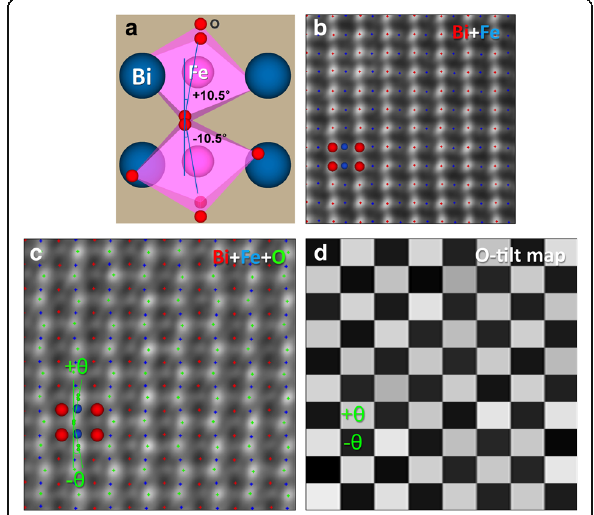
Fig. 2 Measurement of oxygen octahedral tilts in BFO using HAADF and BF STEM images. a Schematic of the BFO structure observed along the [110] pc direction. b , c Simultaneously acquired HAADF and BF STEM images overlaid with peak finding results for the atomic columns. Bi (red) and Fe (blue) atomic columns can be defined from the HAADF STEM image ( b ) and oxygen columns from the BF STEM image ( c ). d A checkerboard pattern generated from the measurements of the projected tilt angles (± θ ) of oxygen octahedra. Reproduced from Kim et al. 2017. Copyright 2017 with permission from